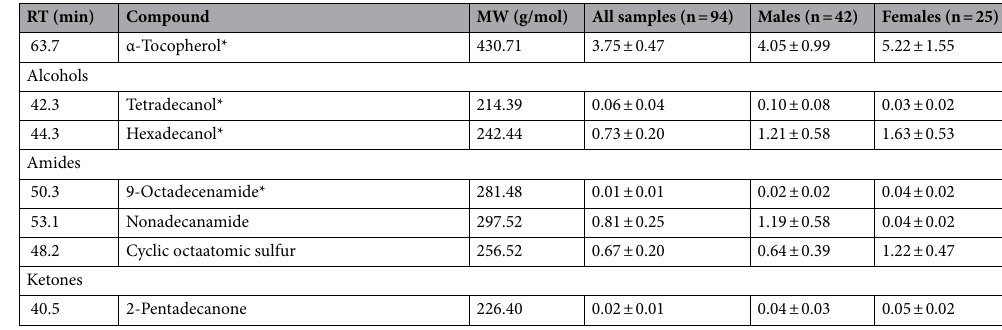
Table 1. Relative proportion (mean ± SE) of lipophilic compounds found in hexane extracts of feces of all adult Iberian wolves ( Canis lupus signatus ), and of males and females separately in fecal samples from which sex was determined. The relative amount of each component was determined as the percent of the total ion current (TIC). An asterisk after the compound name indicates that the identification was confirmed with standards. The other compounds were tentatively identified based on mass spectra and retention times (RT). Characteristic ions ( m/z ) are reported for an unidentified steroid. MW molecular